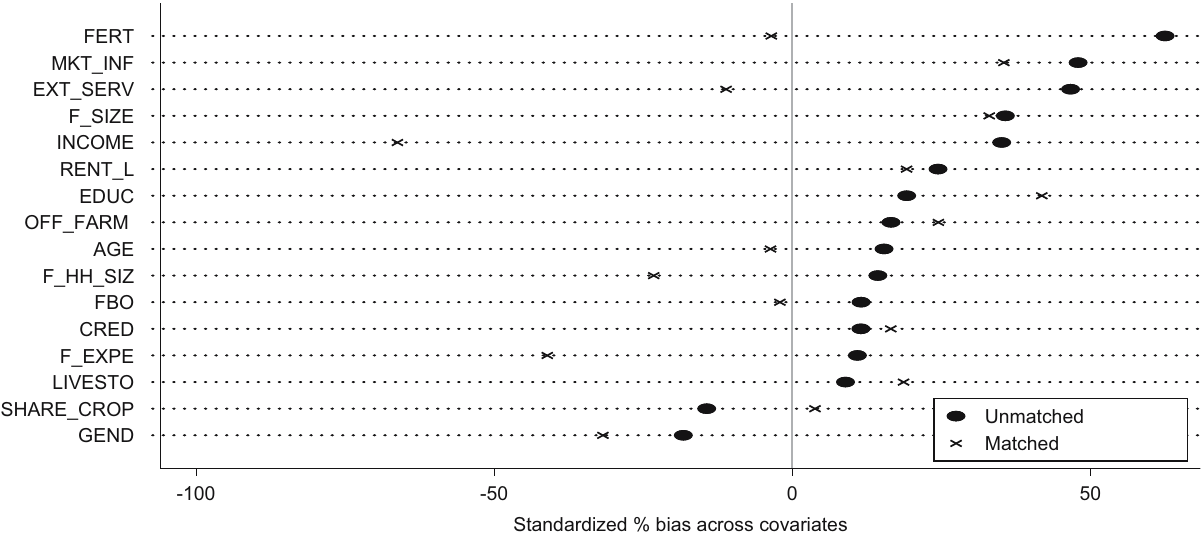
Figure 2: Standardized bias across covariates before and after